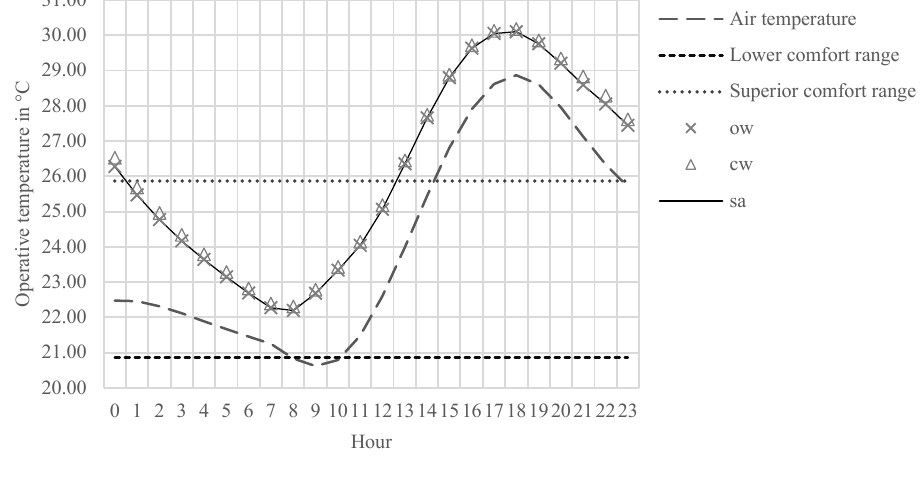
Fig. 7. Operative temperature analysis for March